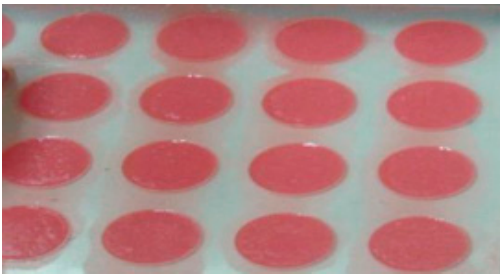
Figure 1. Acrylic mold for the preparation of slices of guava pure.